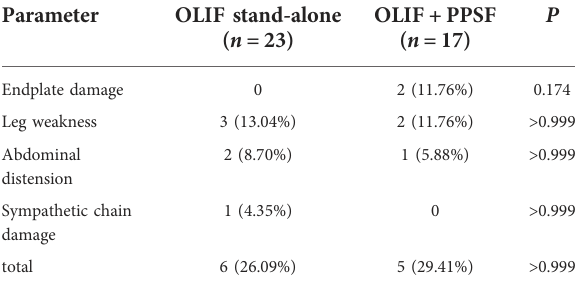
TABLE 5 Complications outcomes.